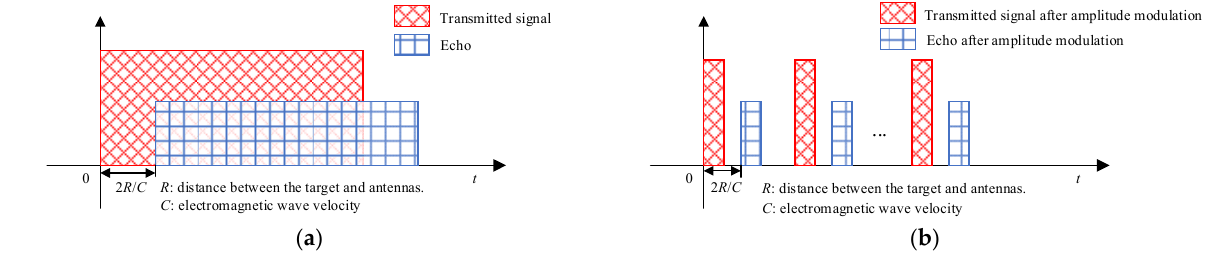
Figure 1. Signal coupling and decoupling by amplitude modulation: ( a ) Coupling diagram; ( b ) Decoupling by amplitude modulation.